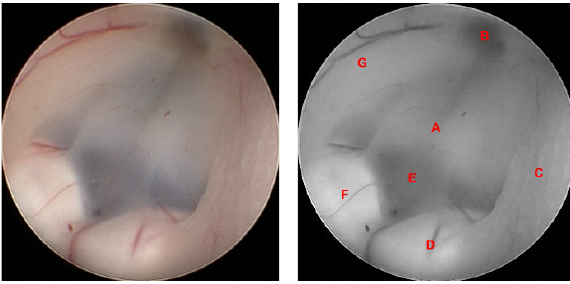
Fig. 15. Tuber cinereum (A), infundibular recess (B), right hypothalamus (C), right mammillary body (D), premammillary recess (E), left mammillary body (F), left hypothalamus (G).